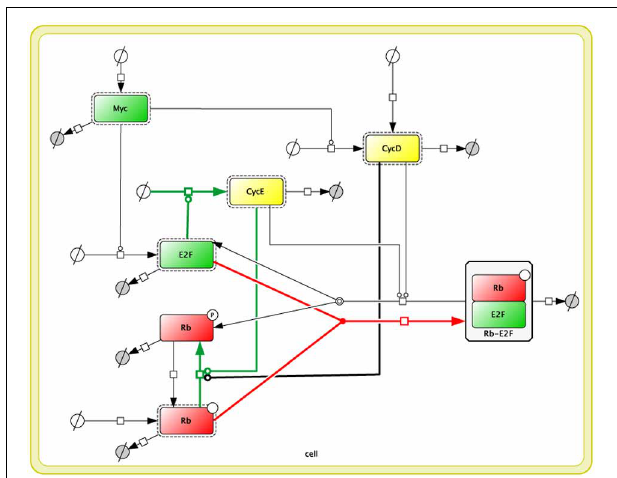
FIGURE 1 | Reconstructed diagram of Yao’s 2008 model (Yao et al., 2008) in Cell Designer (Funahashi et al., 2008). Each square indicates protein, and rectangles with dotted lines indicate activated forms of those proteins. The whole the diagram is included inside a compartment, which represents a cell, with double yellow lines. White circles with a crossing line indicate a reactant source, and gray circles with a crossing line indicate waste. All edges correspond to the fluxes from a reaction species to the